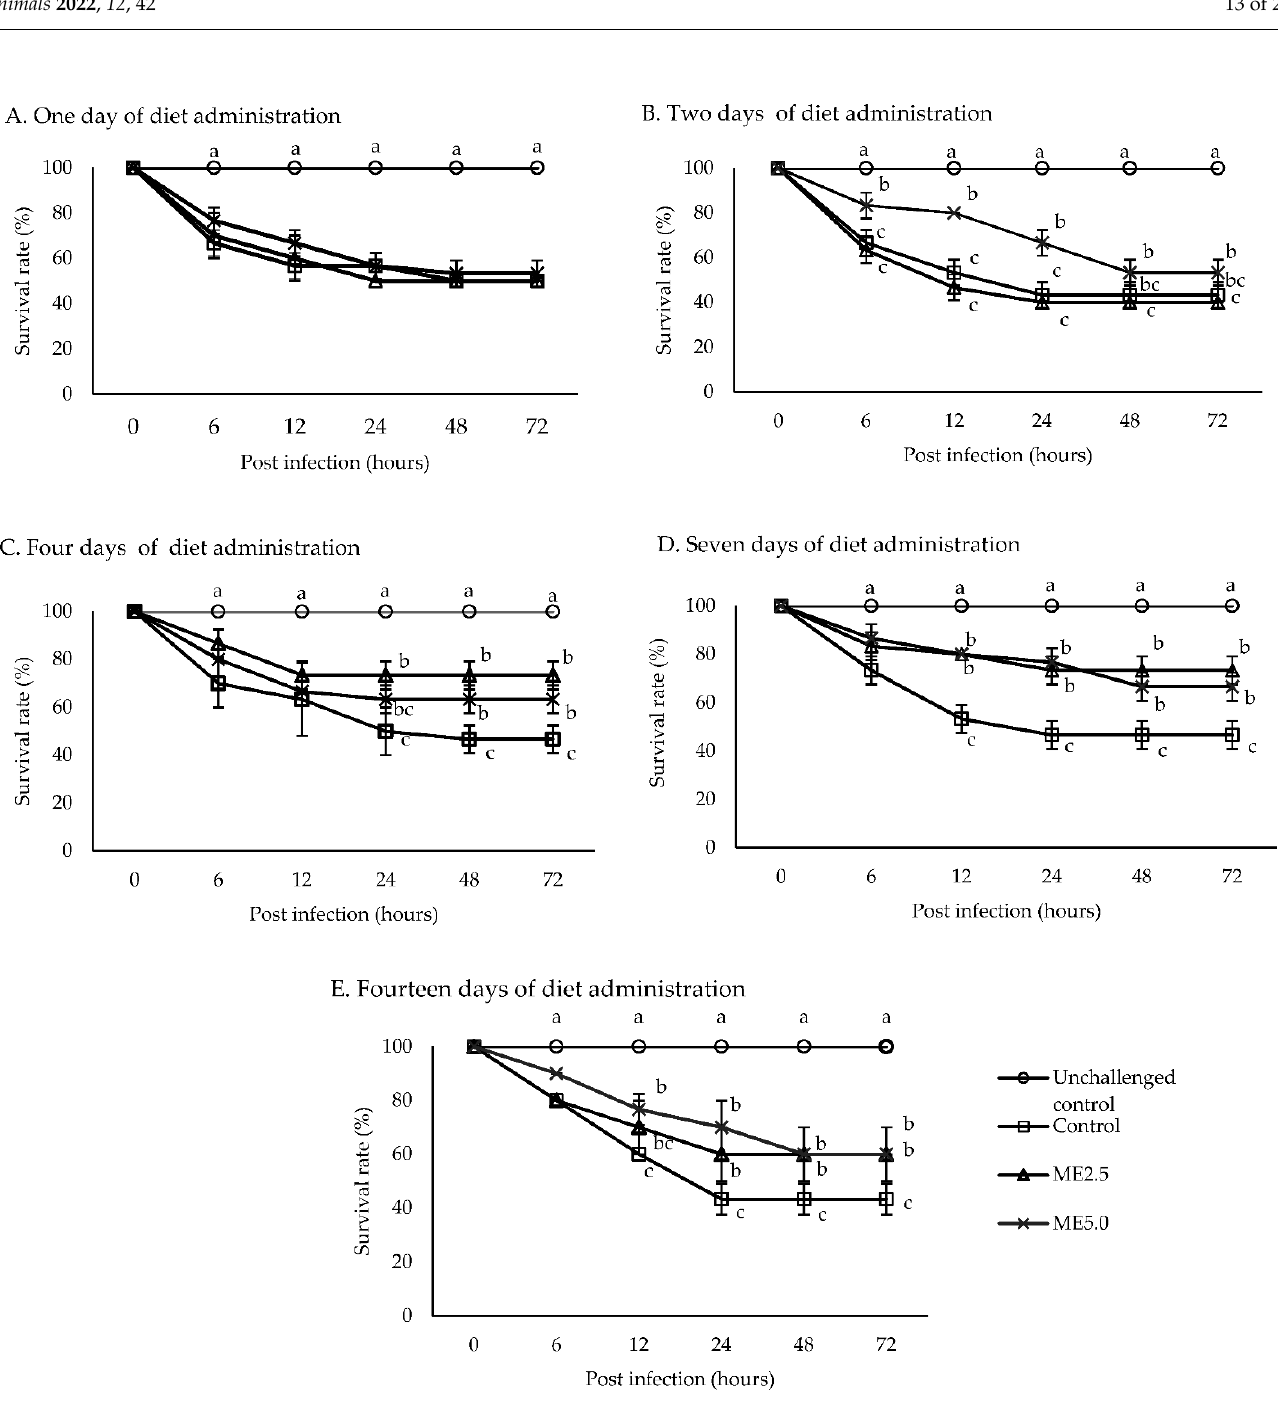
Figure 6. Survival rate during 72 h of whiteleg shrimp fed the dietary moringa extract (control, ME2.5, ME5.0) for 1, 2, 4, 7, and 14 days and then challenged with V. alginolyticus . The data are expressed as the mean ± standard deviation ( n = 3). Bars with different letters at the same time point are significantly different ( p < 0.05).